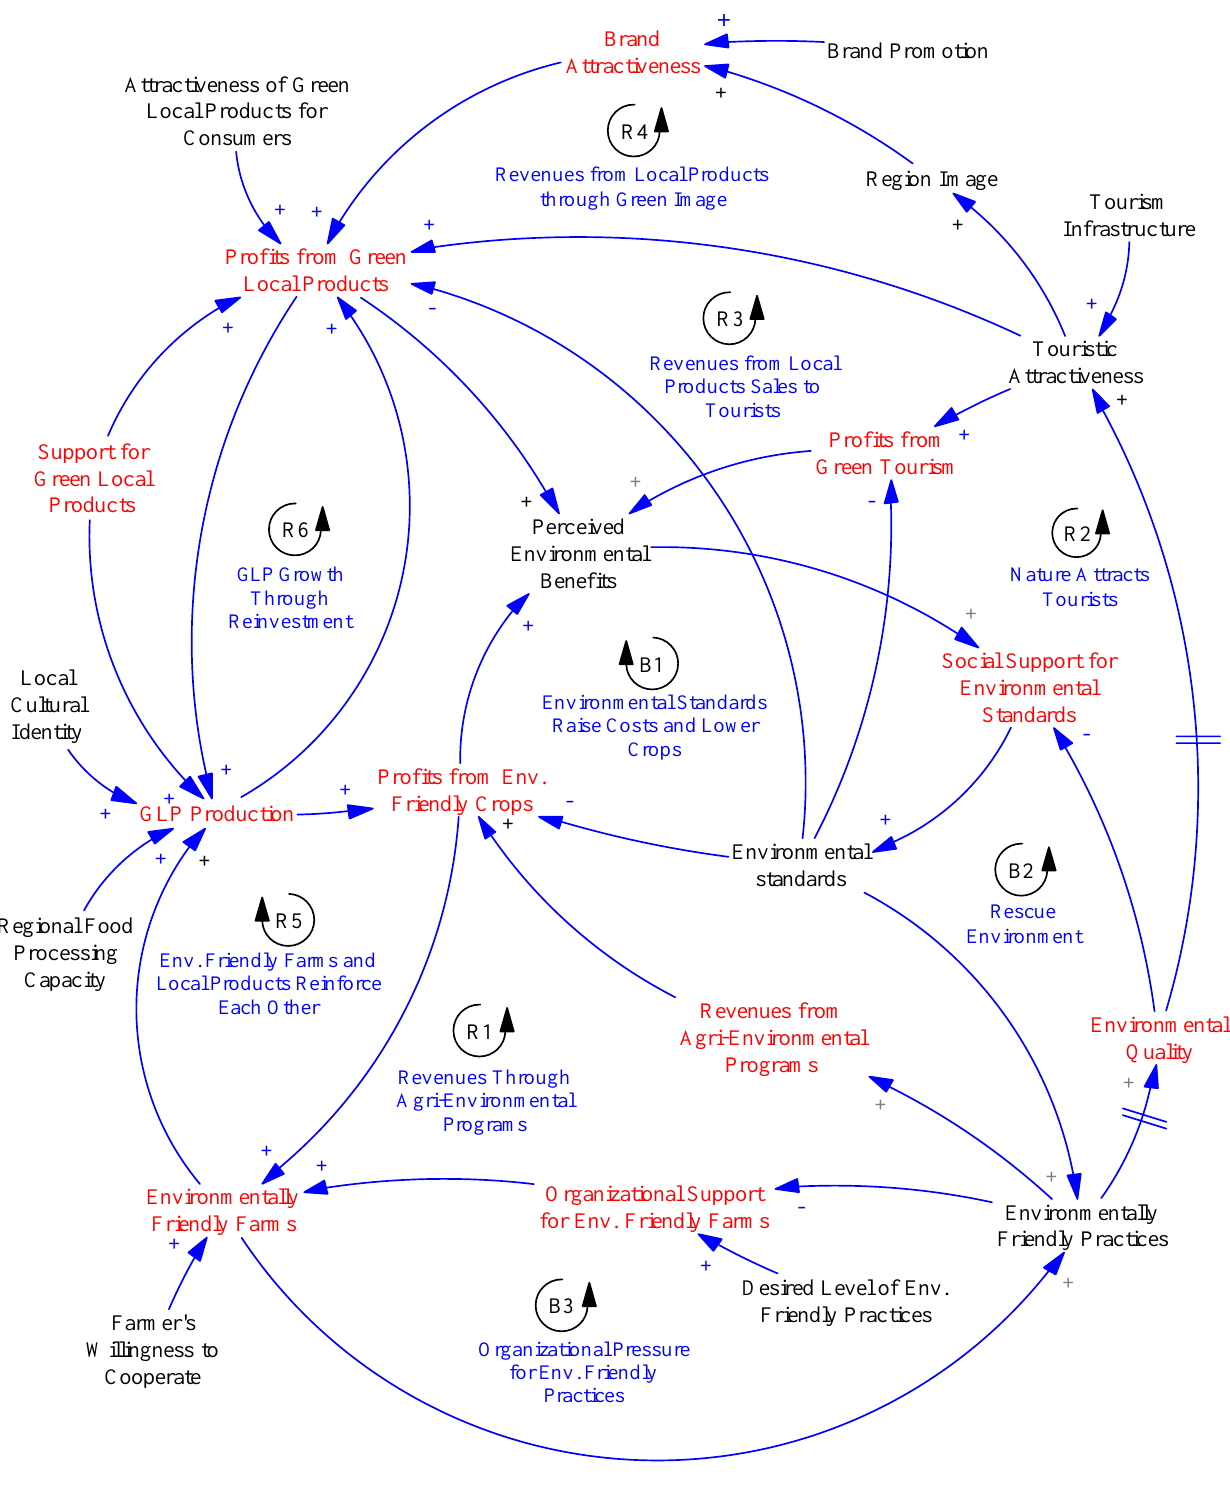
Figure 4: Variables and causal links in the Environmentally Friendly Farms sub-model. Variables in red are the key variables, which were used to find sustainability